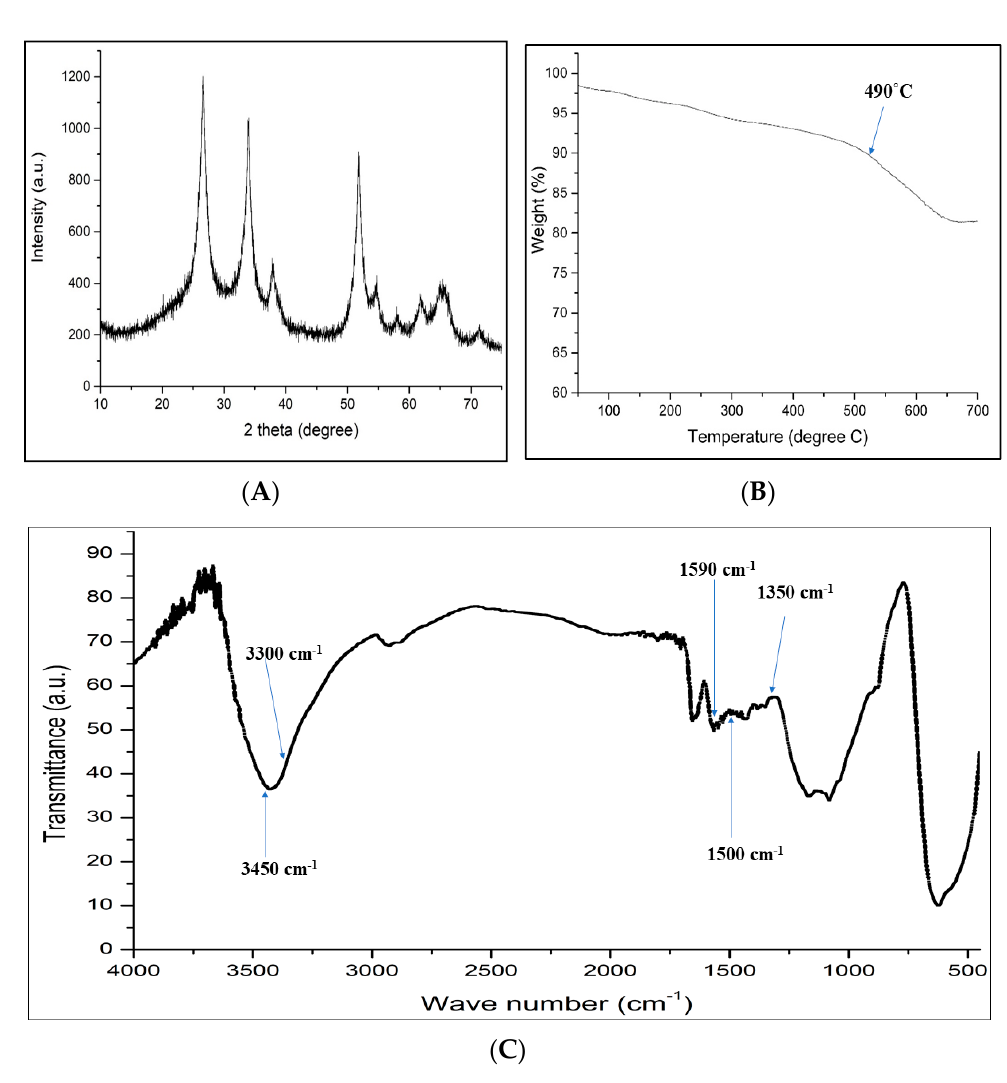
Figure 2. Image of ( A ) XRD, ( B ) TGA, and ( C ) FTIR images of GCT.